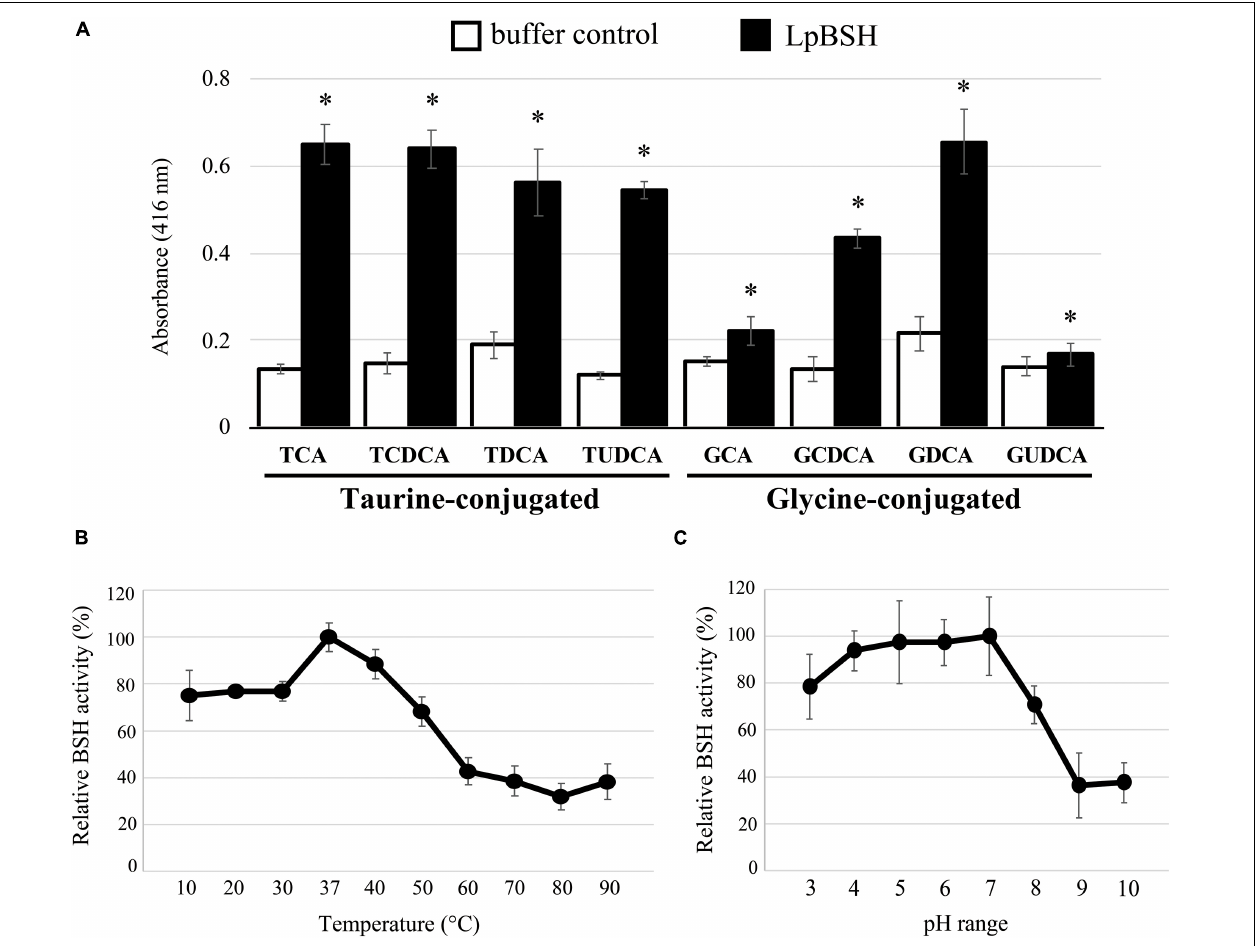
FIGURE 2 | BSH activity and biochemical characterization of LpBSH. (A) BSH activity was measured against eight human bile salts: taurocholic acid (TCA), taurochenodeoxycholic acid (TCDCA), taurodeoxycholic acid (TDCA), tauroursodeoxycholic acid (TUDCA), glycocholic acid (GCA), glycochenodeoxycholic acid (GCDCA), glycodeoxycholic acid (GDCA), and glycoursodeoxycholic acid (GUDCA). Values are indicated as means for three independent experiments ( n = 24, ∗ p < 0.05). Error bars represent standard deviation (SD). Effects of temperature (B) and pH (C) on BSH activity against TDCA. Each value is expressed as mean values for eight technical replicates (each n = 8). Maximum activity was taken as 100%. Error bars indicate